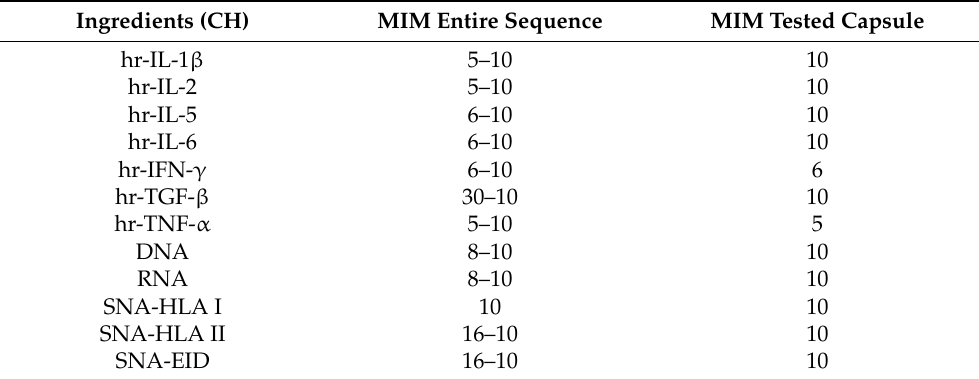
Table 1. Composition of the complete sequence of the MIM (in vivo experiment) and the tested capsule (in vitro